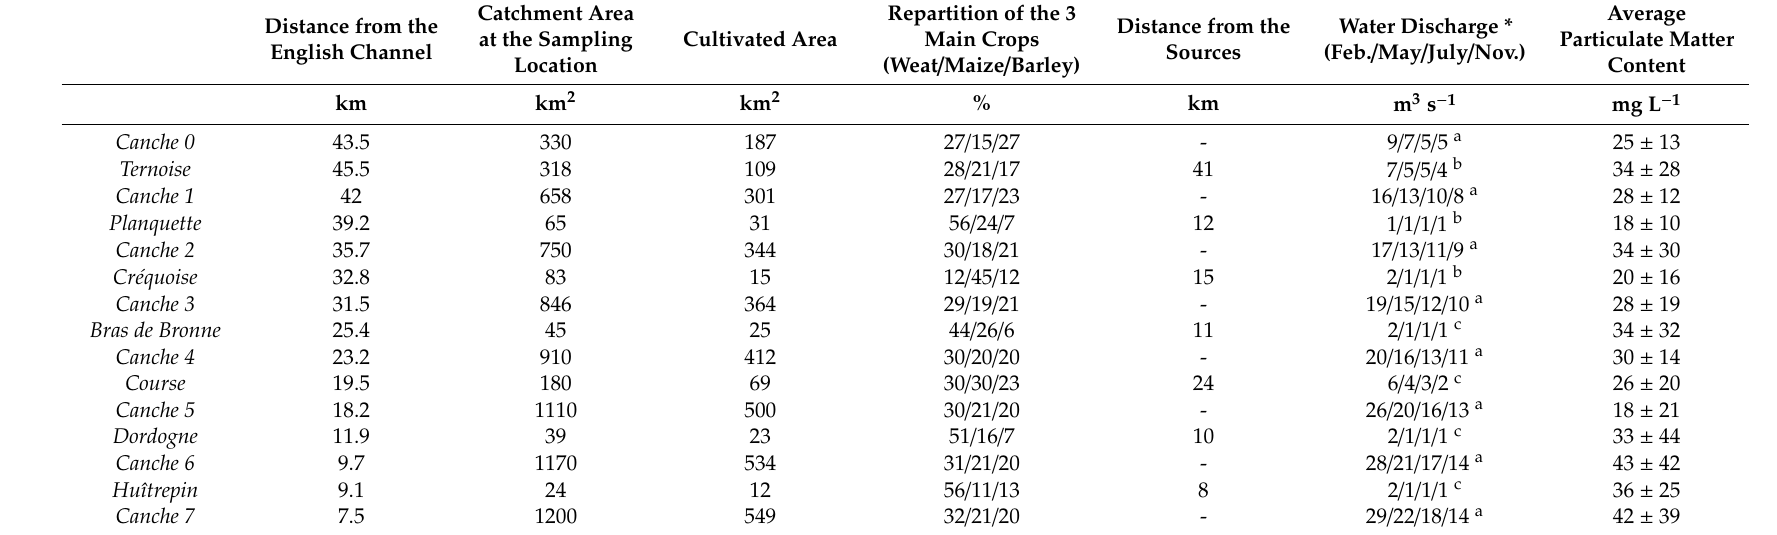
Table 1. Hydrological parameters and land use of the Canche watershed for the studied period. All sampling sites named as “ Canche x ” refer to sampling points on the main stream of the